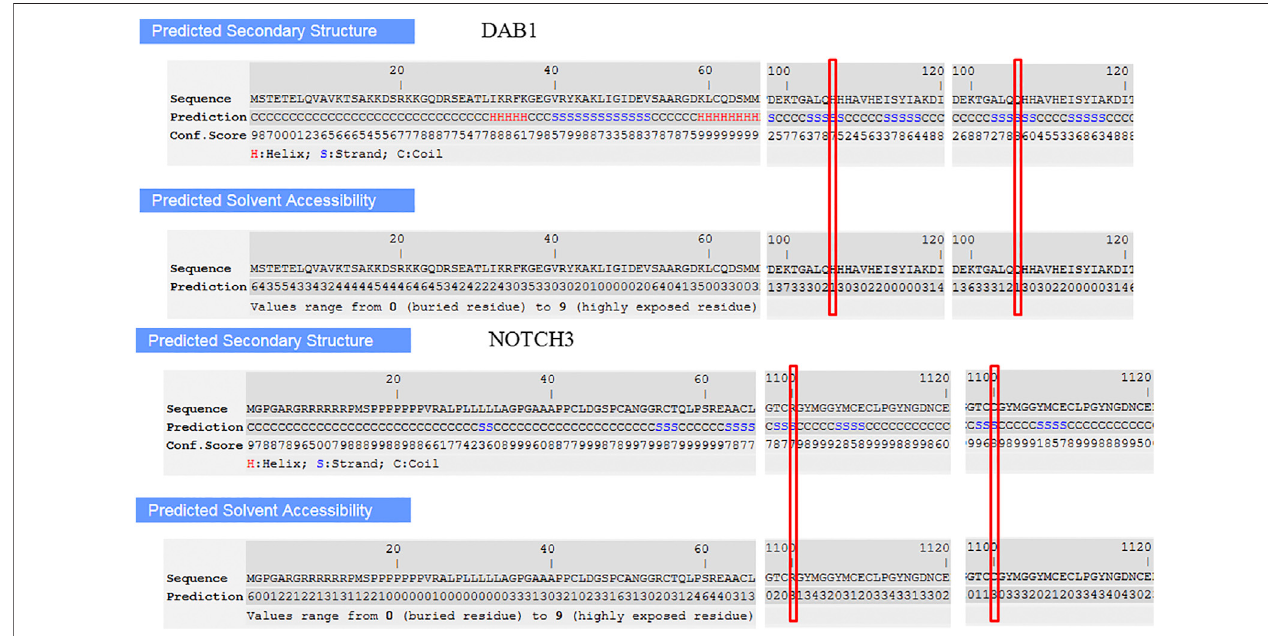
FIGURE 5 | Secondary structure and solvent accessibility of wild and mutant type in DAB1 and NOTCH3 gene predicted by I-TASSER server, respectively.